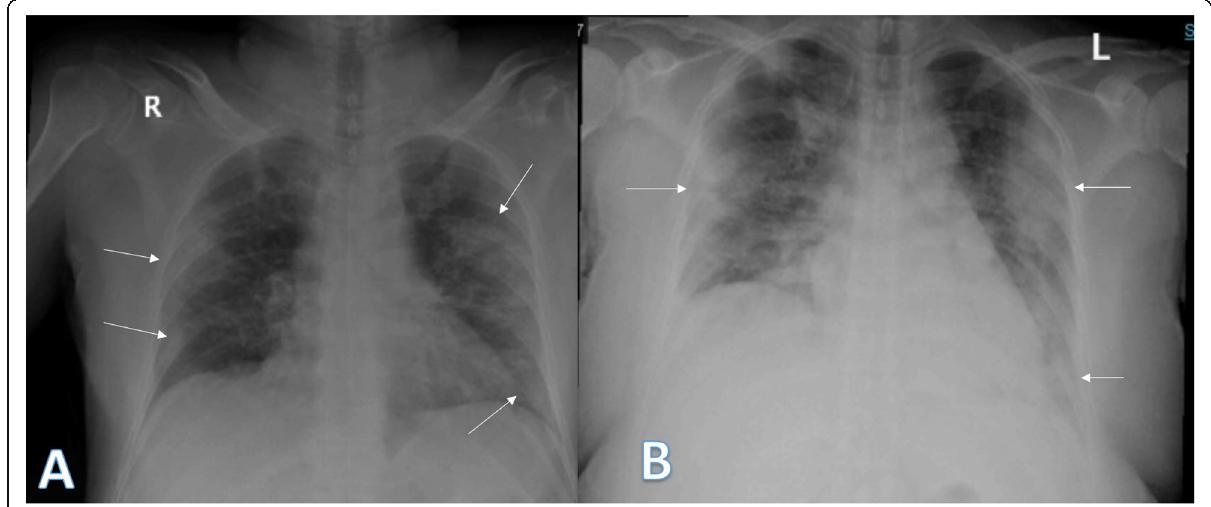
Fig. 6 Two different patients with positive COVID-19. a 52-year male was complaining of fever, SOB, and cough. Initial chest X-ray showed right (peripheral) and left mid and lower zonal air space consolidation opacities with midzonal predominance (arrows). The severity score was 2 for the right lung and 3 on the left lung, so TSS was 5. b 36-year female was complaining of cough and fever. Initial chest X-ray showed mid and lower zonal air space consolidation opacities on both lungs with midzonal predominance (arrows). The severity score was 2 for the right lung and 3 on the left lung, so TSS was